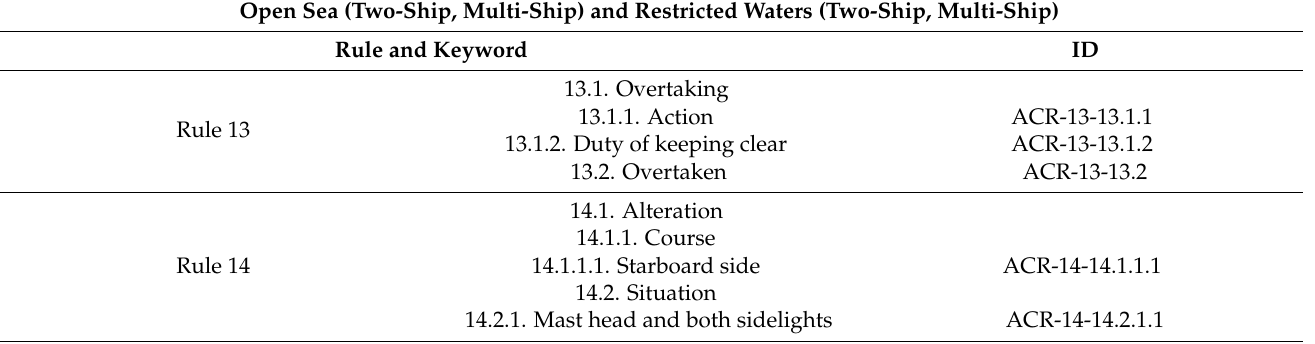
Table A1. Requirements specifications for ship anti-collision responsibility (give-way